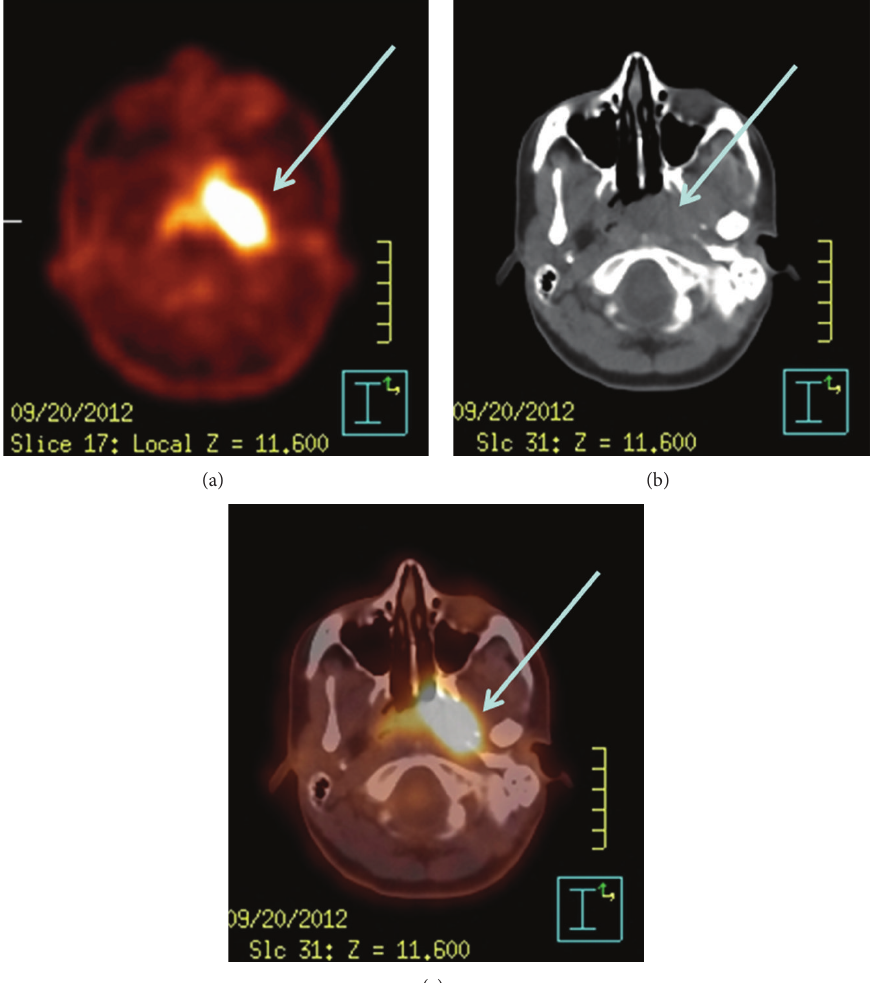
Figure 2: Images showing intense 18F-FDG uptake in rhinopharynx: (a) PET, (b) CT, and (c) PET-CT.